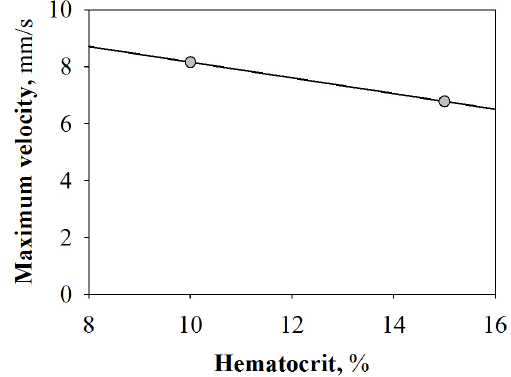
Figure 3. Plot of maximum velocities of FNP/RBC suspensions as a function of Hct at an imposed wall shear.